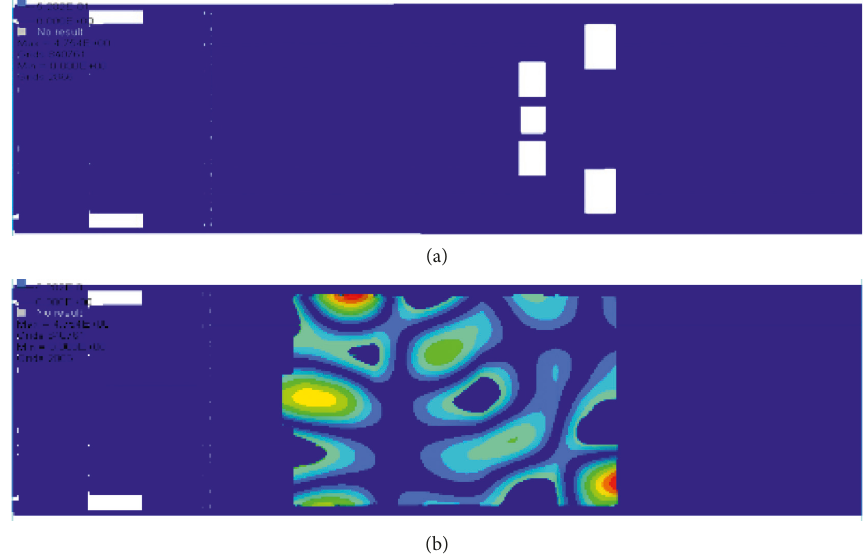
Figure 15: Modal shape comparison between (a) underframe of car body (58 Hz) and (b)